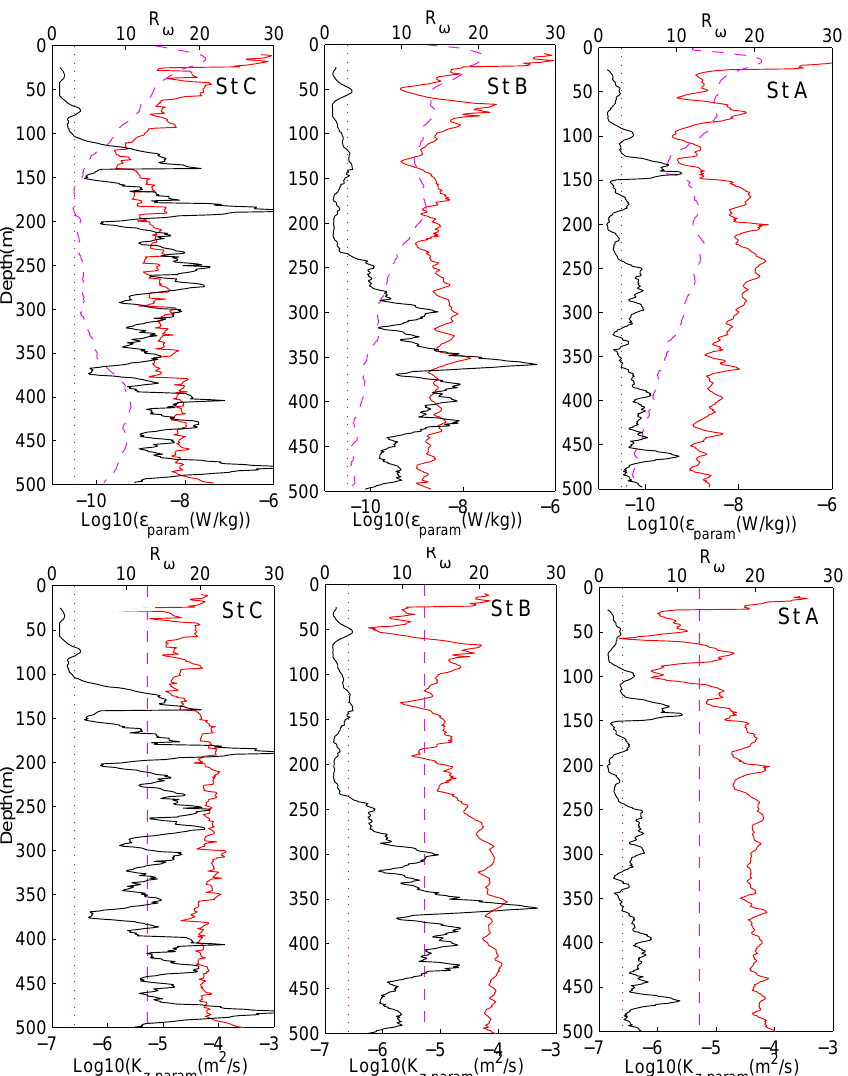
Figure 12: First row: arithmetic mean of ϵ param (red), ϵ GM (dashed magenta) and R ω (black) for the three LD stations (A, B, C), the red dotted line indicates the R ω,GM = 3 value. Second row: arithmetic mean of K z,param (blue), K z GM profiles (dashed magenta) and R ω (black) for the three LD stations (A, B, C), the red dotted line indicates the R ω,GM = 3 value